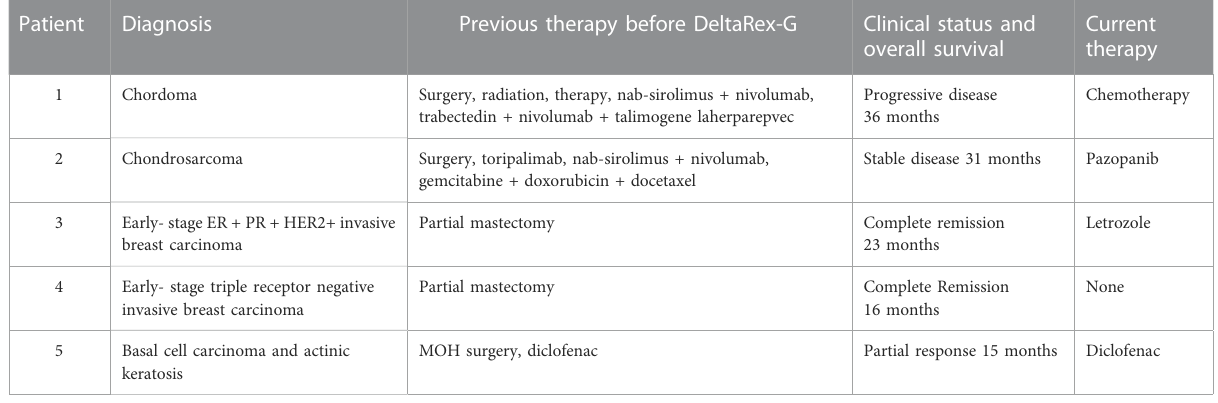
TABLE 3 Listing of surviving patients, clinical status, and current